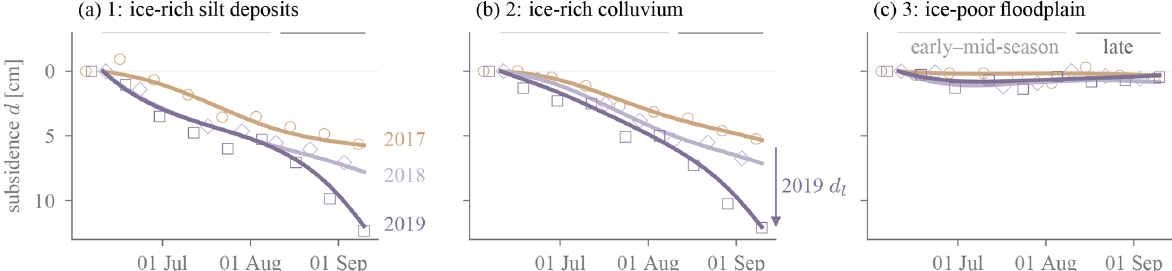
Figure 6. Cumulative subseasonal subsidence (line: spline fit, markers: unconstrained) from all 3 years. The late-season subsidence (10 August–10 September) is highlighted for the year 2019 in (b) . The locations of (a) – (c) are shown in Fig. 7c.